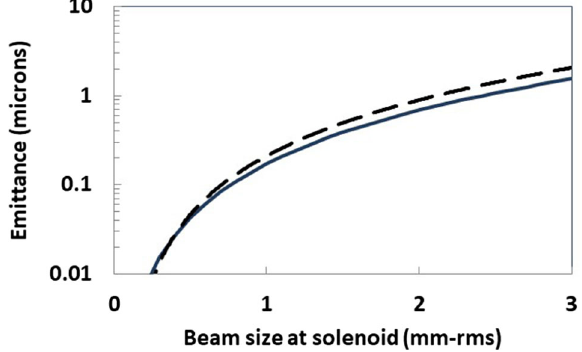
FIG. 3. Normalized emittance due to the quadrupole-solenoid coupling given by Eq. (19) (solid line) and by a particle tracking simulation (dashed line) for the case of the LCLS solenoid. For a beam energy of 6 MeV, the quadrupole focal length was 50 m. This corresponds to an integrated quadrupole field of 4.3 G. The solenoid had an integrated field of 0.046 T-m, giving a focal length of ∼ 12 cm. The simulation is done with the GPT code [16].